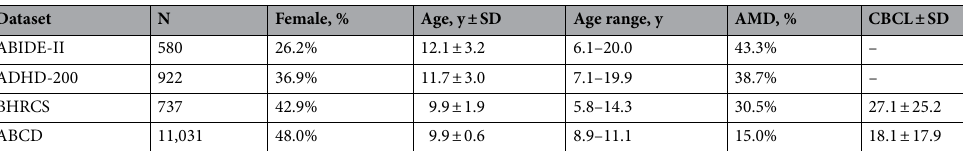
Table 1. Subjects’ demographic and phenotypic information. The sample size (N) is shown in numbers. Age is in years ± standard deviation and range of minimum–maximum years of age. The CBCL total score is a raw scale. Subjects with Any Mental Disorder are grouped in AMD. For ABIDE-II, AMD contains subjects with different levels of the autism spectrum, while ADHD-200 AMD includes different subtypes of ADHD. For both BHRCS and ABCD datasets, AMD comprises subjects with at least one diagnostic of mental disorders according to DSM-IV (for BHRCS) or DSM-V (for ABCD).